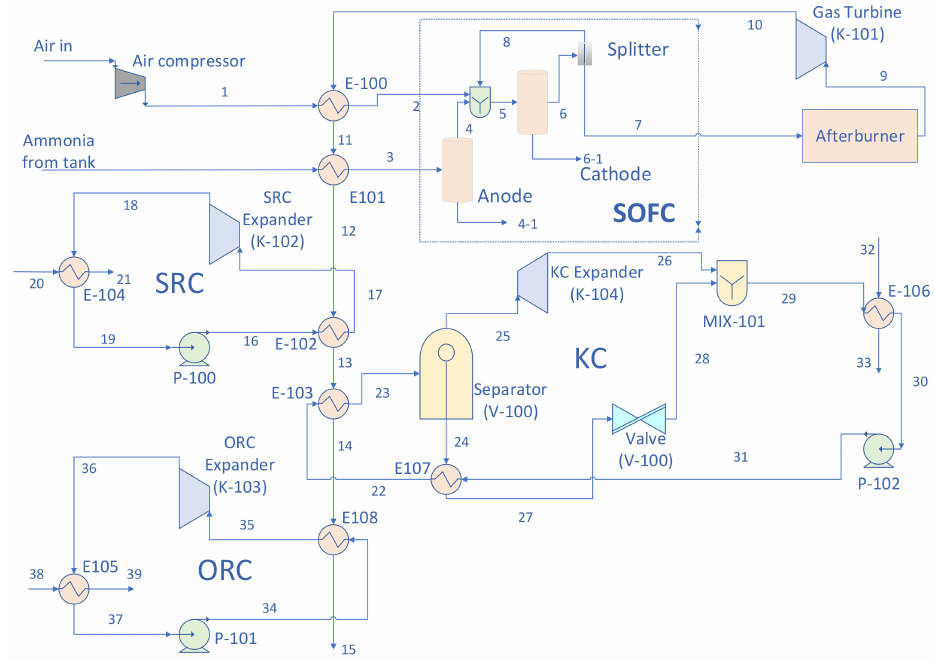
Figure 2. Schematic of the SOFC–GT–SRC–ORC–KC system employing ammonia as fuel. The subsystem coupling connection must be compatible with the exhaust gas